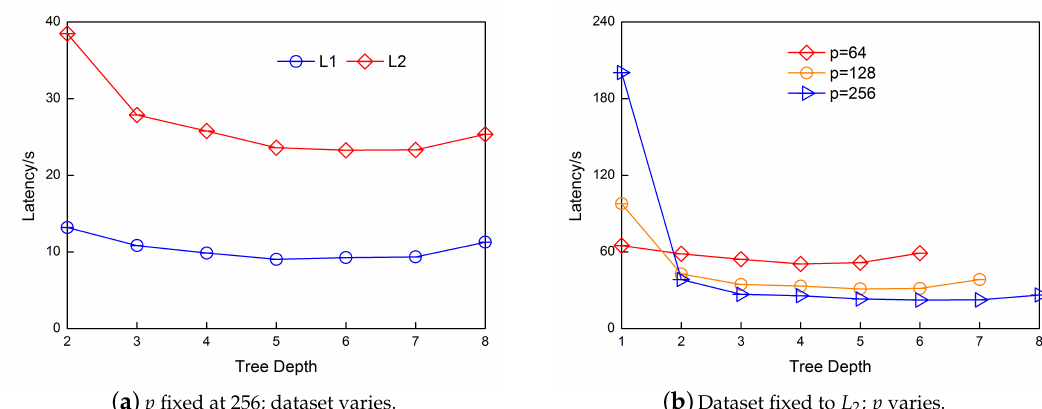
Figure 11. Experiment on the